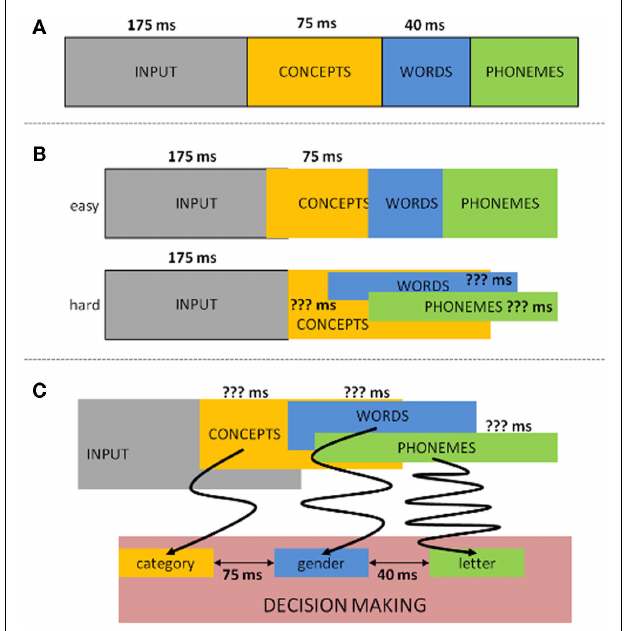
FIGURE 2 |Time latency representation of the LRP/N200 dual-task button-press ERP studies. (A) Traditional way latencies in this paradigm are allocated. (B) Alternative allocation of the LRP/N200 latencies when taking into account difficulty. (C) Another alternative allocation of the LRP/N200 latencies from the perspective of decision making.The arrows schematically (simplified) represent the possible amount of noise during evidence